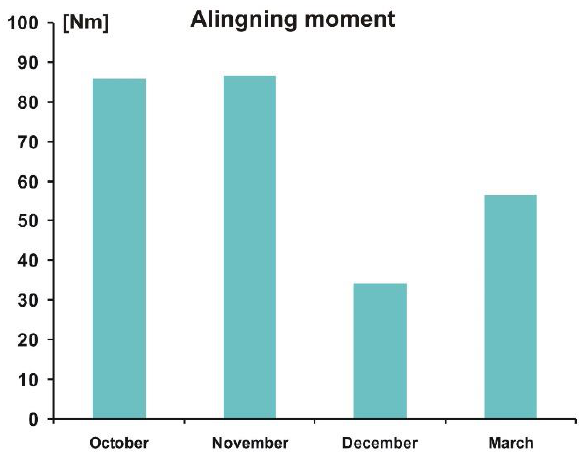
Figure 16. Average peak values of aligning moment, M Z , for the four measurements.